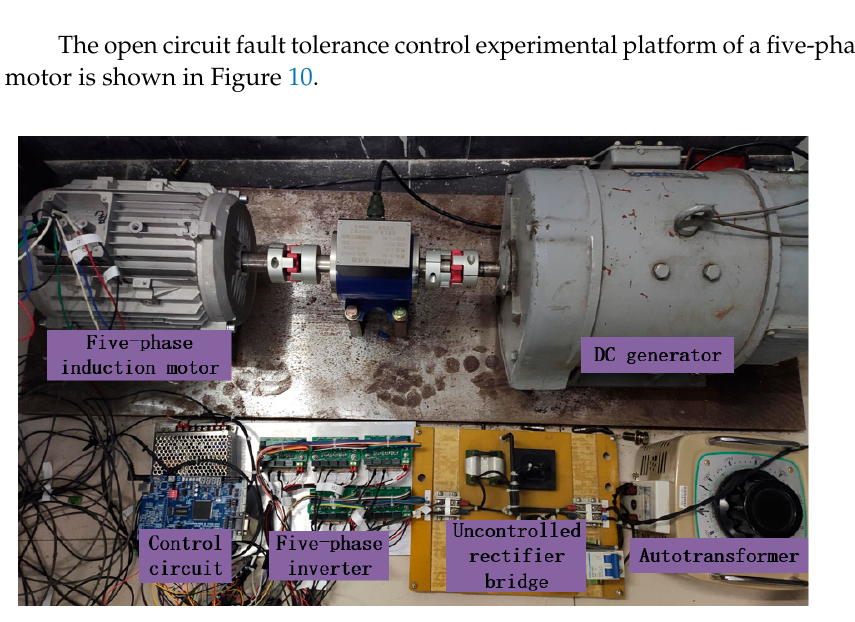
Figure 10. Wiring diagram of open-phase experiment